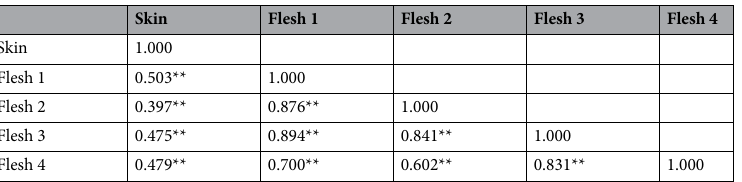
Table 1. Correlations between anthocyanin contents in samples of skin and fleshes at different depths. Person’s correlation coefficients were indicated. **Correlation is significant at the 0.01 level (2-tailed).